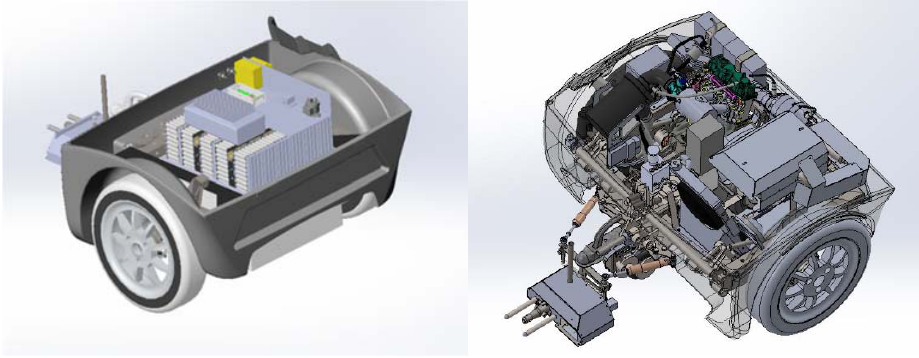
Figure 2. Graphical representation of the generator trailer ( left ) and the battery trailer ( right ).